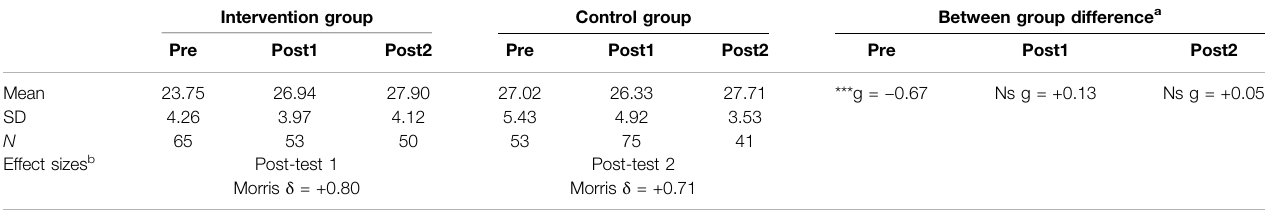
TABLE 4 | Teachers ’ collective ef fi cacy comparison between baseline, post-test 1 and post-test 2 (all educational levels).